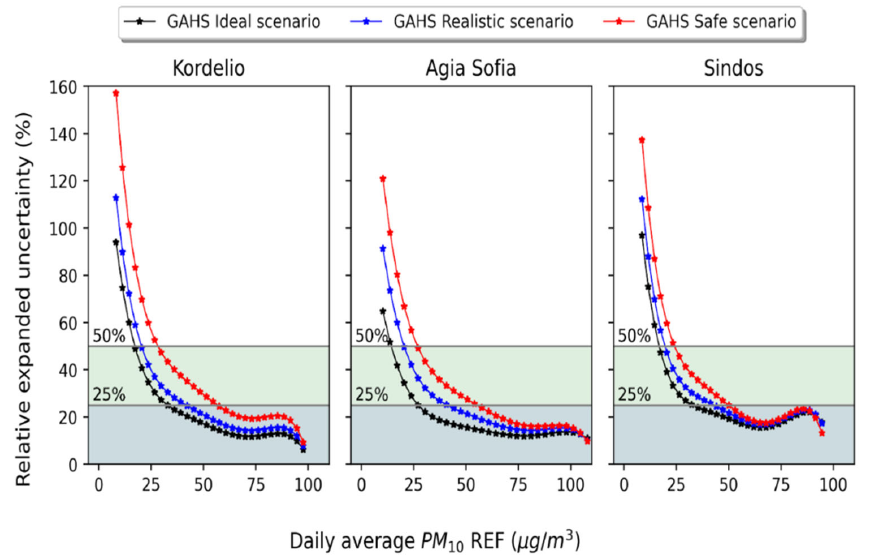
Figure 6. The effect of delaying the training of the online models to the meta learners REU for PM 10 for the three locations where reference LCS are collocated with reference instruments. The presented curves correspond to a fifth polynomial fit on the results.